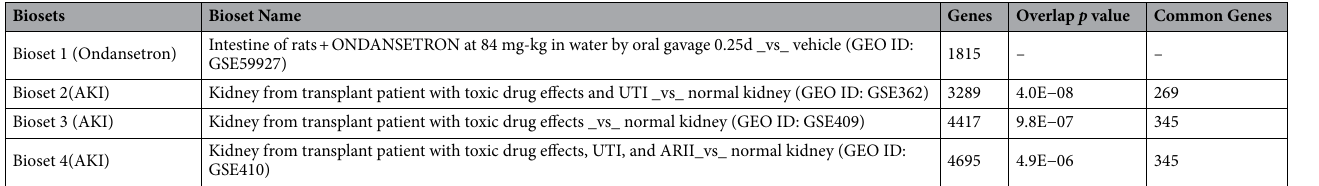
Table 3. Comparation of ondansetron-induced gene expression profiles with three AKI gene expression profiles. UTI: urinary tract infection, ARII: acute rejection type II.